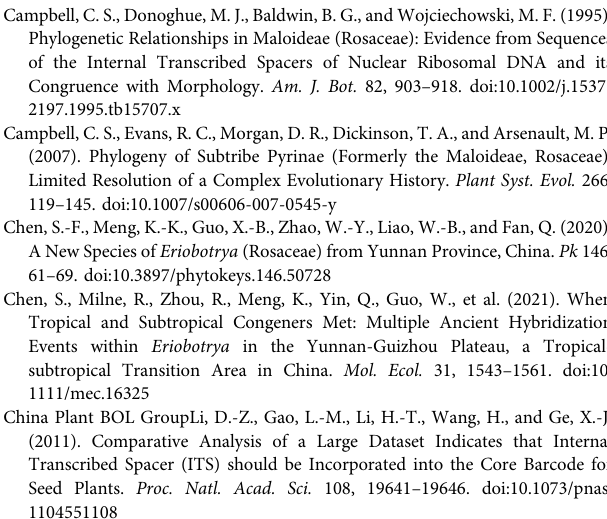
Supplementary Figure S4 | Molecular phylogenetic tree of 97 taxa of Rosaceae basedonnrDNAsequencesusingmaximumparsimony.Numbersat eachnode are the MP bootstrap support values. Supplementary Figure S5 | Molecular phylogenetic tree of 86 taxa of Eriobotrya and Rhaphiolepis and three related taxa of Phippsiomeles , based on the nrDNA sequenceandITS(containingonlyITS1,5.8S,andITS2)sequencesusingmaximum likelihood. SupplementaryFigureS6| PercentageofSNPmutationsinthenrDNA23species of Eriobotrya and 11 species of Rhaphiolepis from this study (A) and 8 species of Supplementary Figure S7 | Heat map of species distribution of Eriobotrya (A) and heat map of species distribution of Rhaphiolepis (B) . Supplementary Figure S8 | Species distribution map of Eriobotrya and Rhaphiolepis . Supplementary Figure S9 | Morphological character reconstruction of Eriobotrya and Rhaphiolepis on the Bayesian phylogenetic tree. Supplementary Table S1 | Sources of plant materials. Supplementary Table S2 | Plant materials for data matrix I. Supplementary Table S3 | Plant materials for data matrix